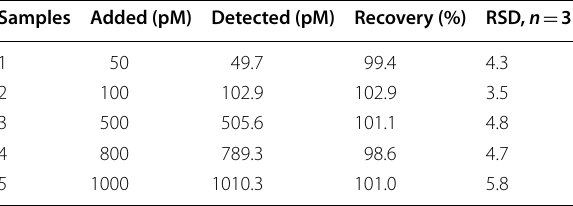
RSD relative standard deviation